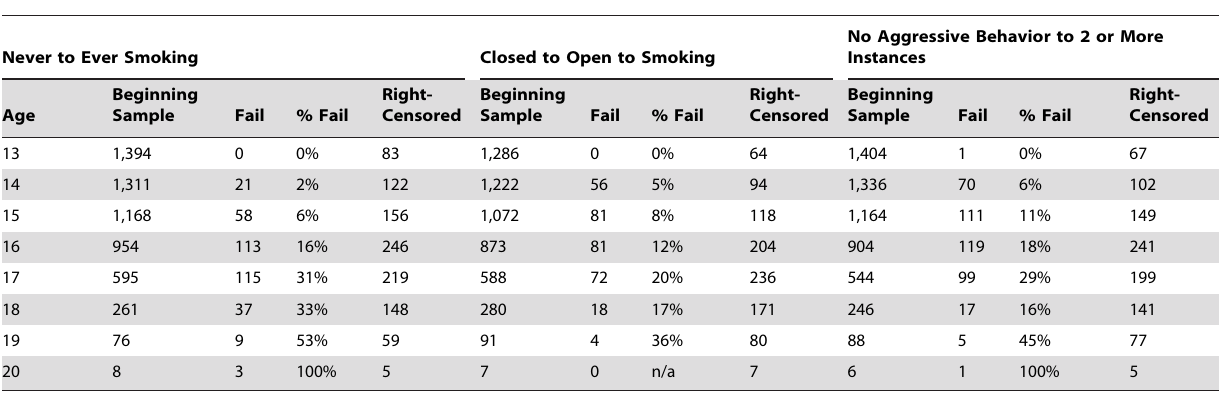
Table 2. Life Tables for the New York Longitudinal Youth Tobacco Evaluation Survey (NY-LYTES), 2005–2008.